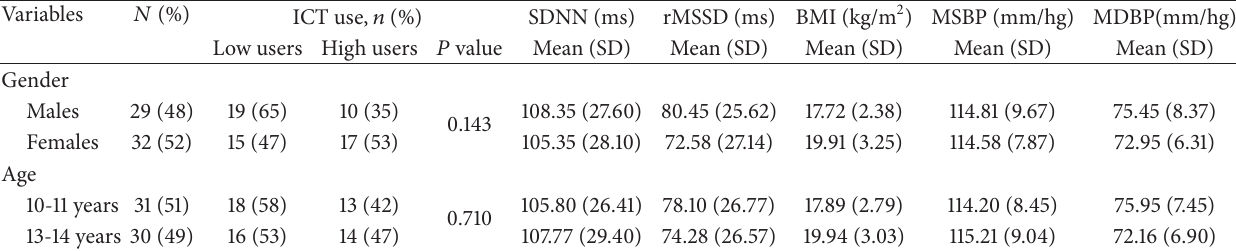
Table 1: Characteristics of study